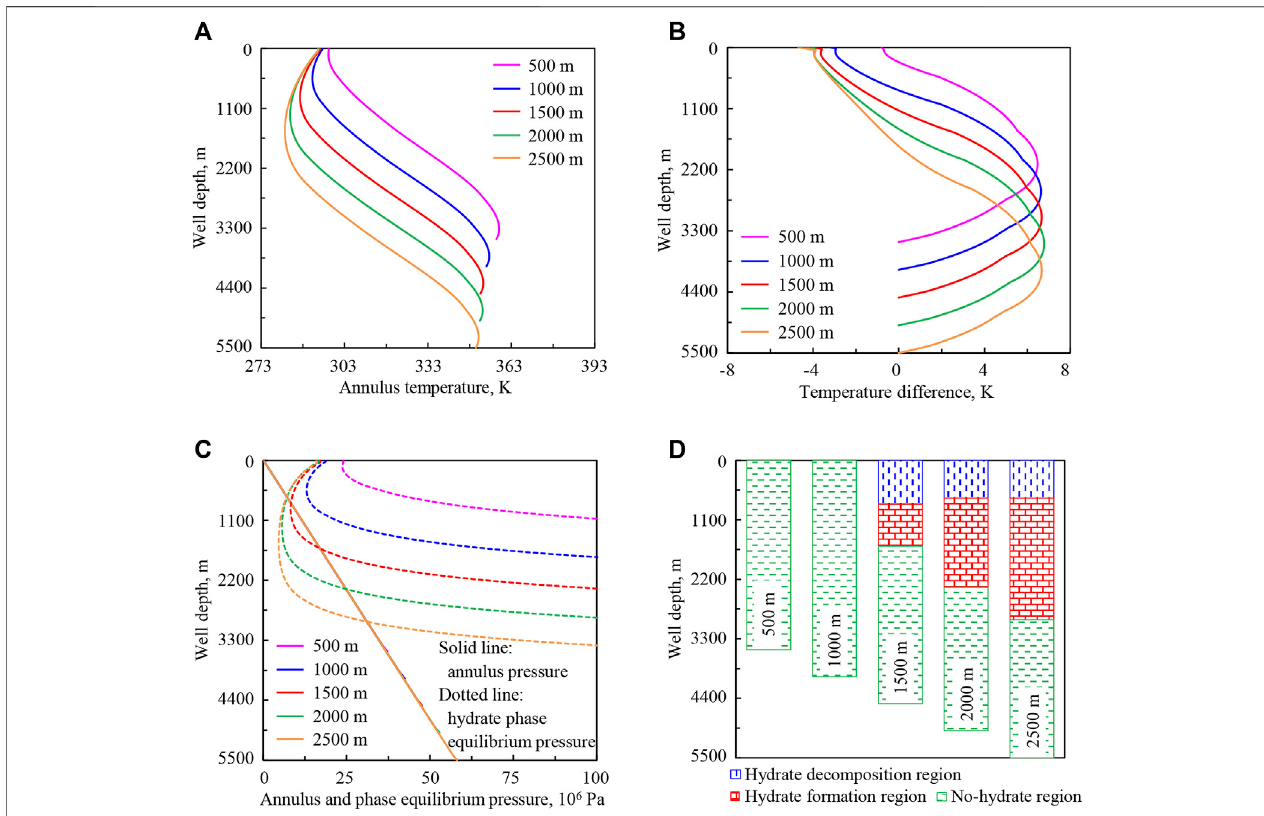
Frontiers in Energy Research |